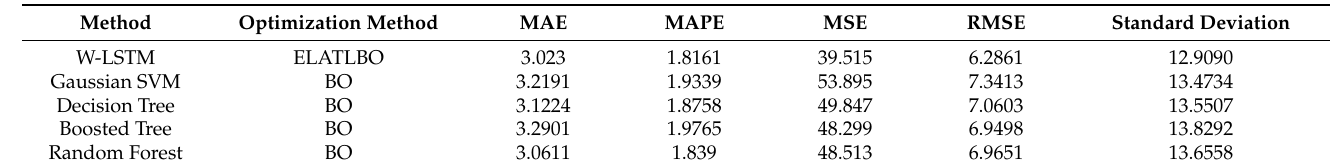
Figure 7. Forecasted and predicted demand of the ESC using the proposed method. Table 3. Test results.